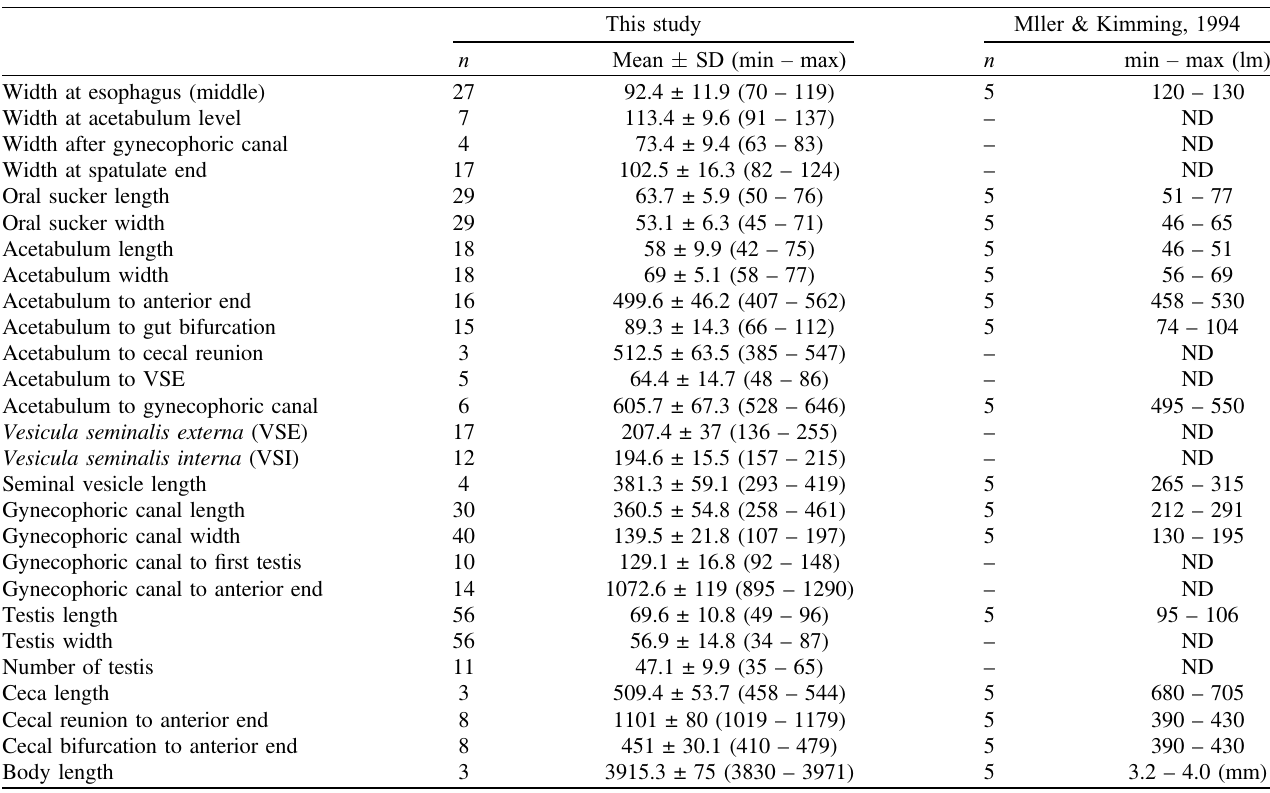
Table 2. Measurements of fresh mounts of male worms from duck hosts Anas platyrhynchos domesticus represented as mean ± SD (min – max l m); ND = no data.